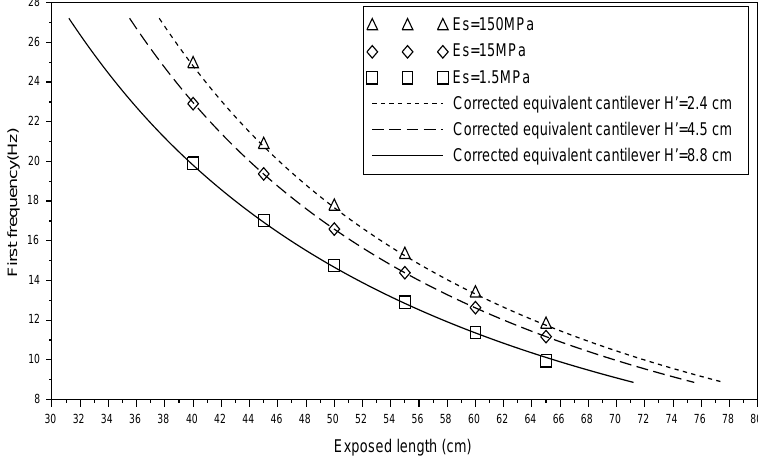
Figure 16. Variation of the adjustment length H (cid:48) with the Young modulus of the soil E s